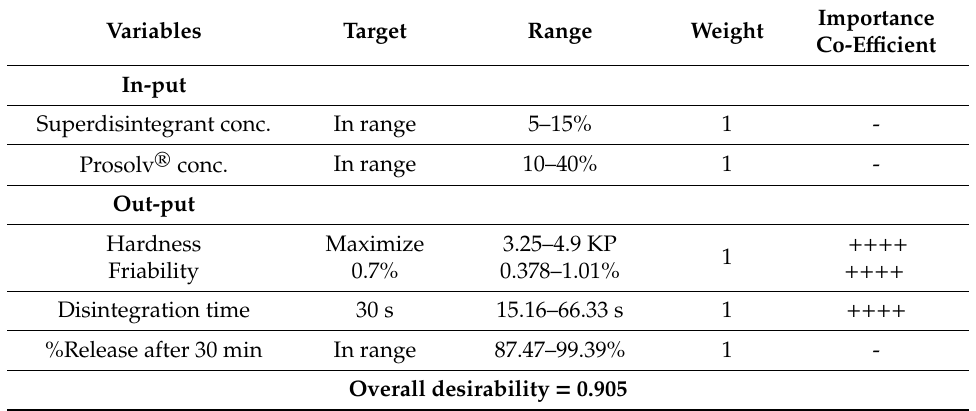
Table 3. Theconstraintsadoptedforoptimizationoftestedvariablesandestimationofoveralldesirability. Variables